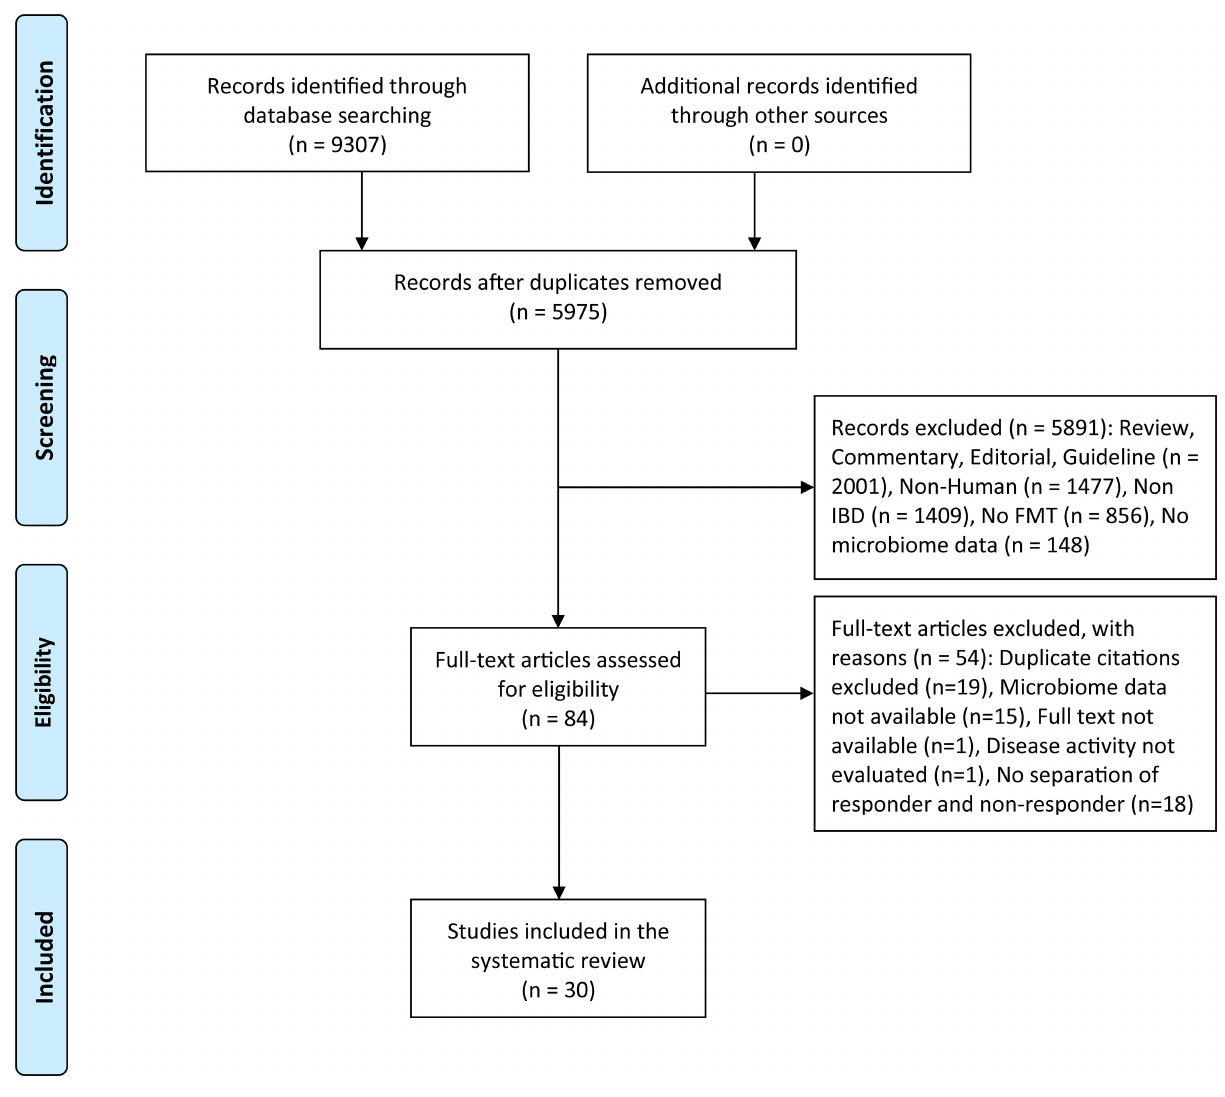
FIGURE 1 | PRISMA flow diagram of the study selection. FMT, fecal microbiota transplantation; IBD, inflammatory Bowel